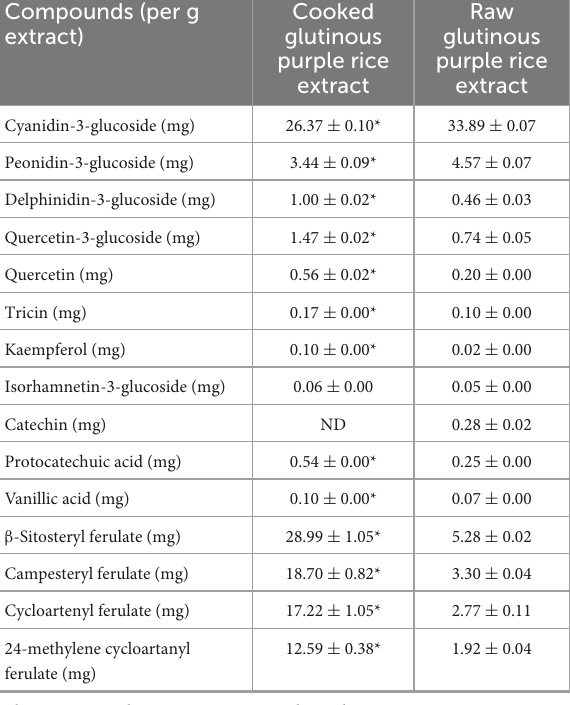
TABLE 2 Phytochemical content in glutinous purple rice extracts analyzed by HPLC. Compounds (per g extract)